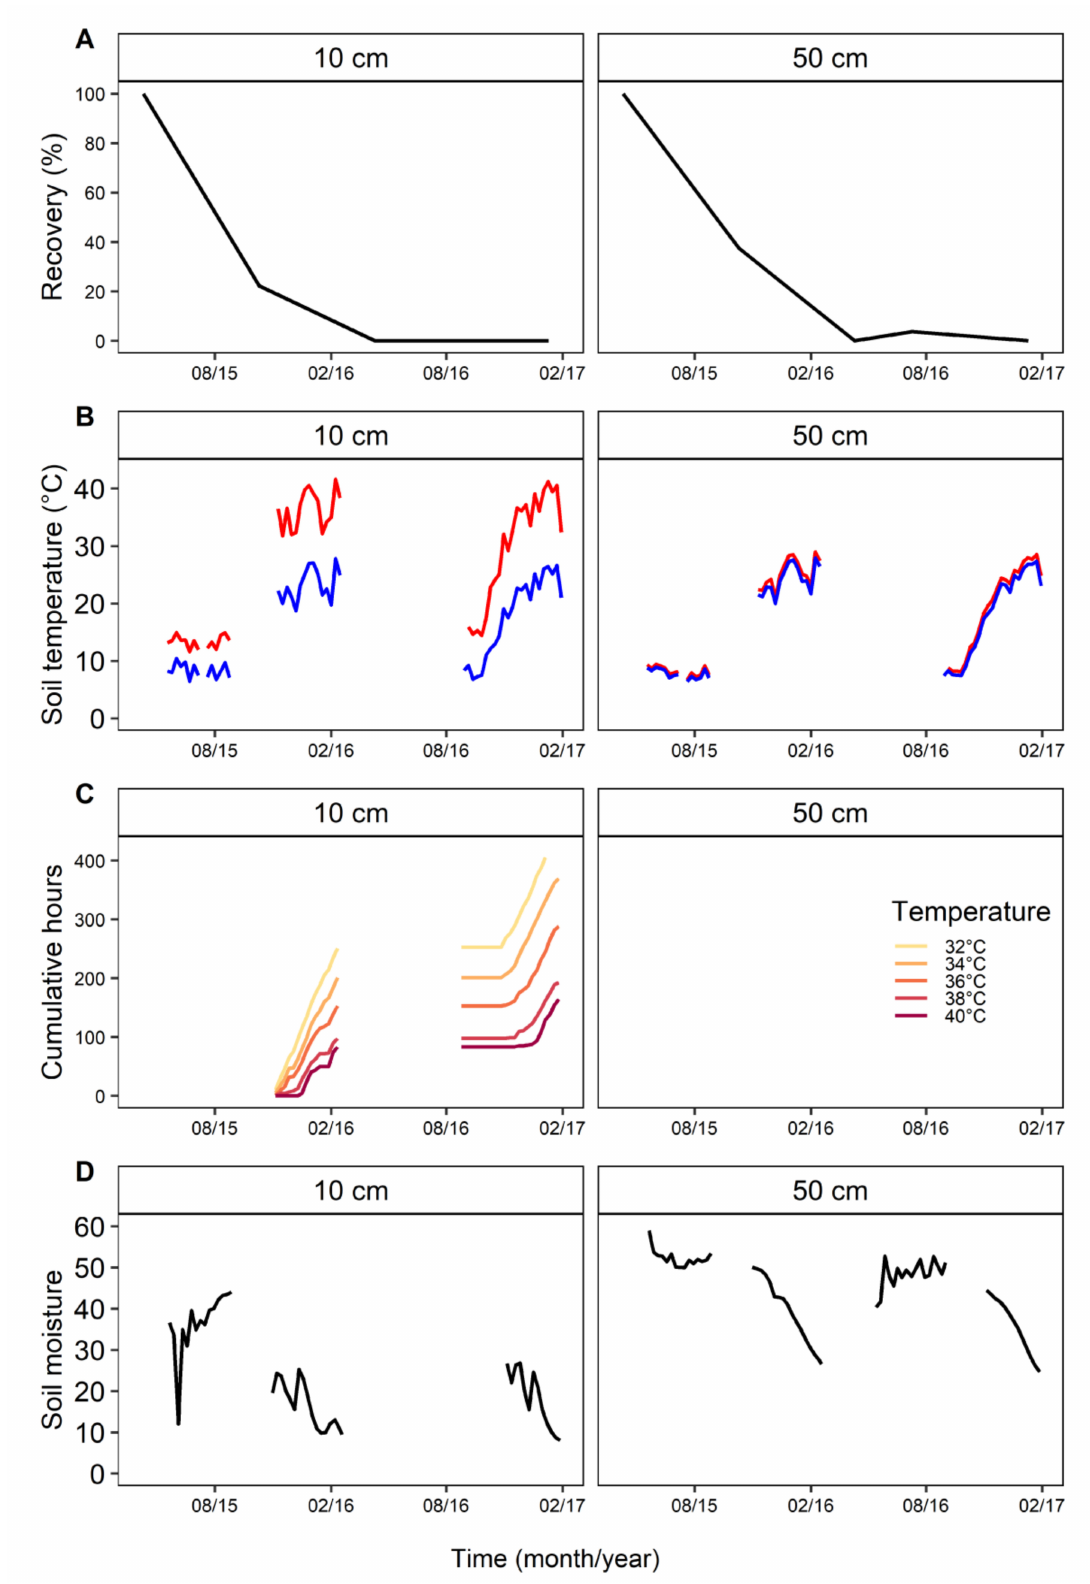
Figure 3. ( A ) Recovery of Phytophthora cinnamomi from Silky Oak Road at 10 and 50 cm depth in relation to ( B ) soil temperatures, ( C ) cumulative number of hours of soil temperatures above 32 ◦ C, and ( D ) soil moisture (%). Gaps in temperature and moisture represent missing